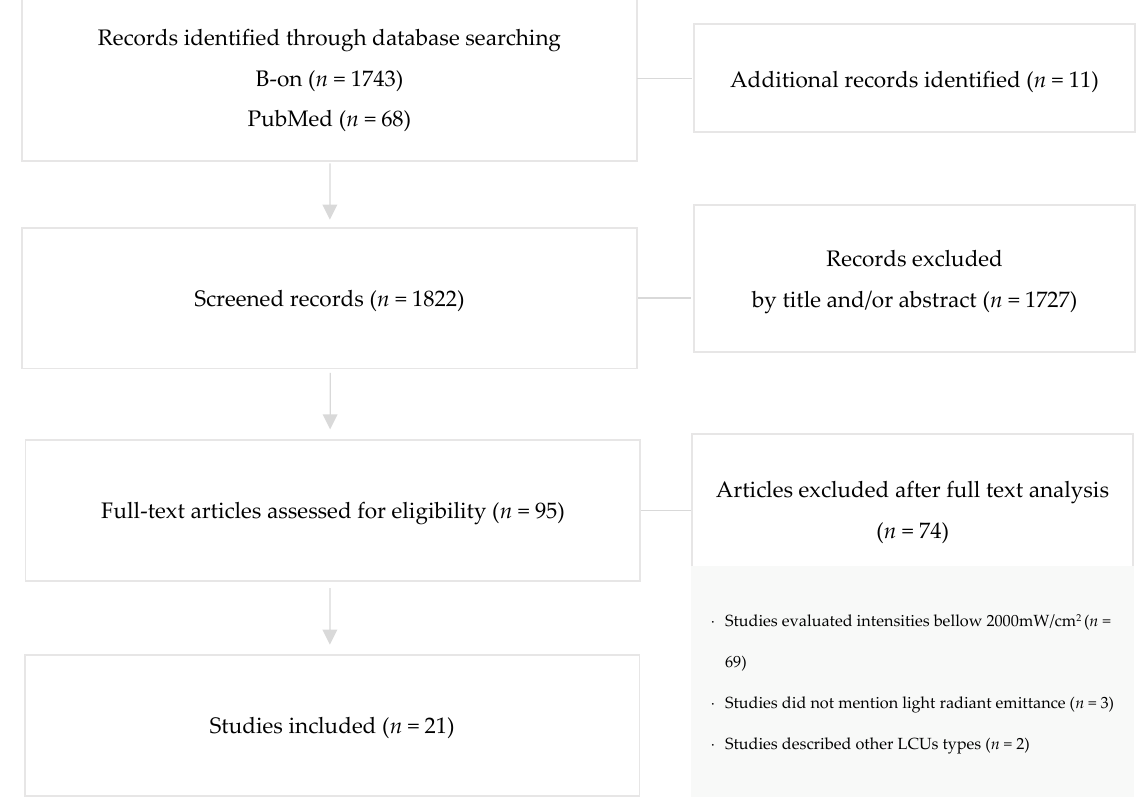
Figure 1. Search flowchart according to PRISMA illustrating study inclusion.